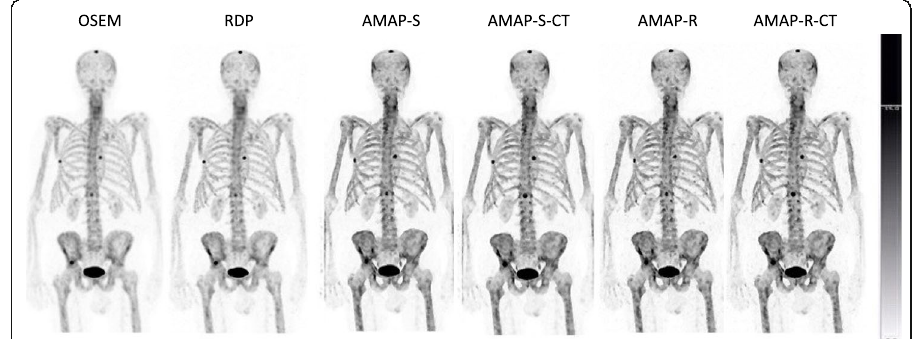
Fig. 3 Anterior maximum intensity projections of the male patient study with artificial lesions. AMAP-S and AMAP-R refer to reconstructions where lesion is absent in the CT and AMAP-S CT and AMAP-R CT to lesion- present cases. The color scale is set to SUV 15 for all